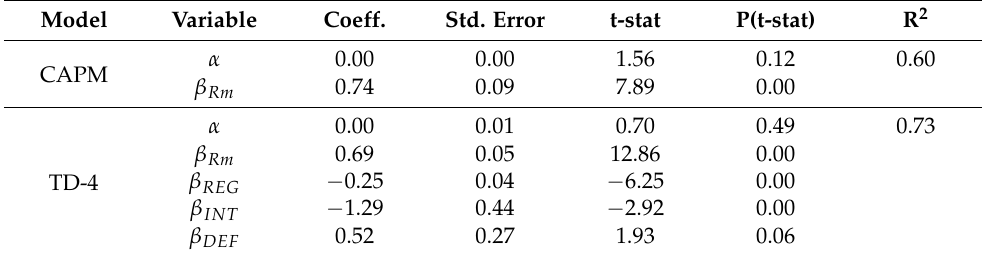
Table 5. Regression